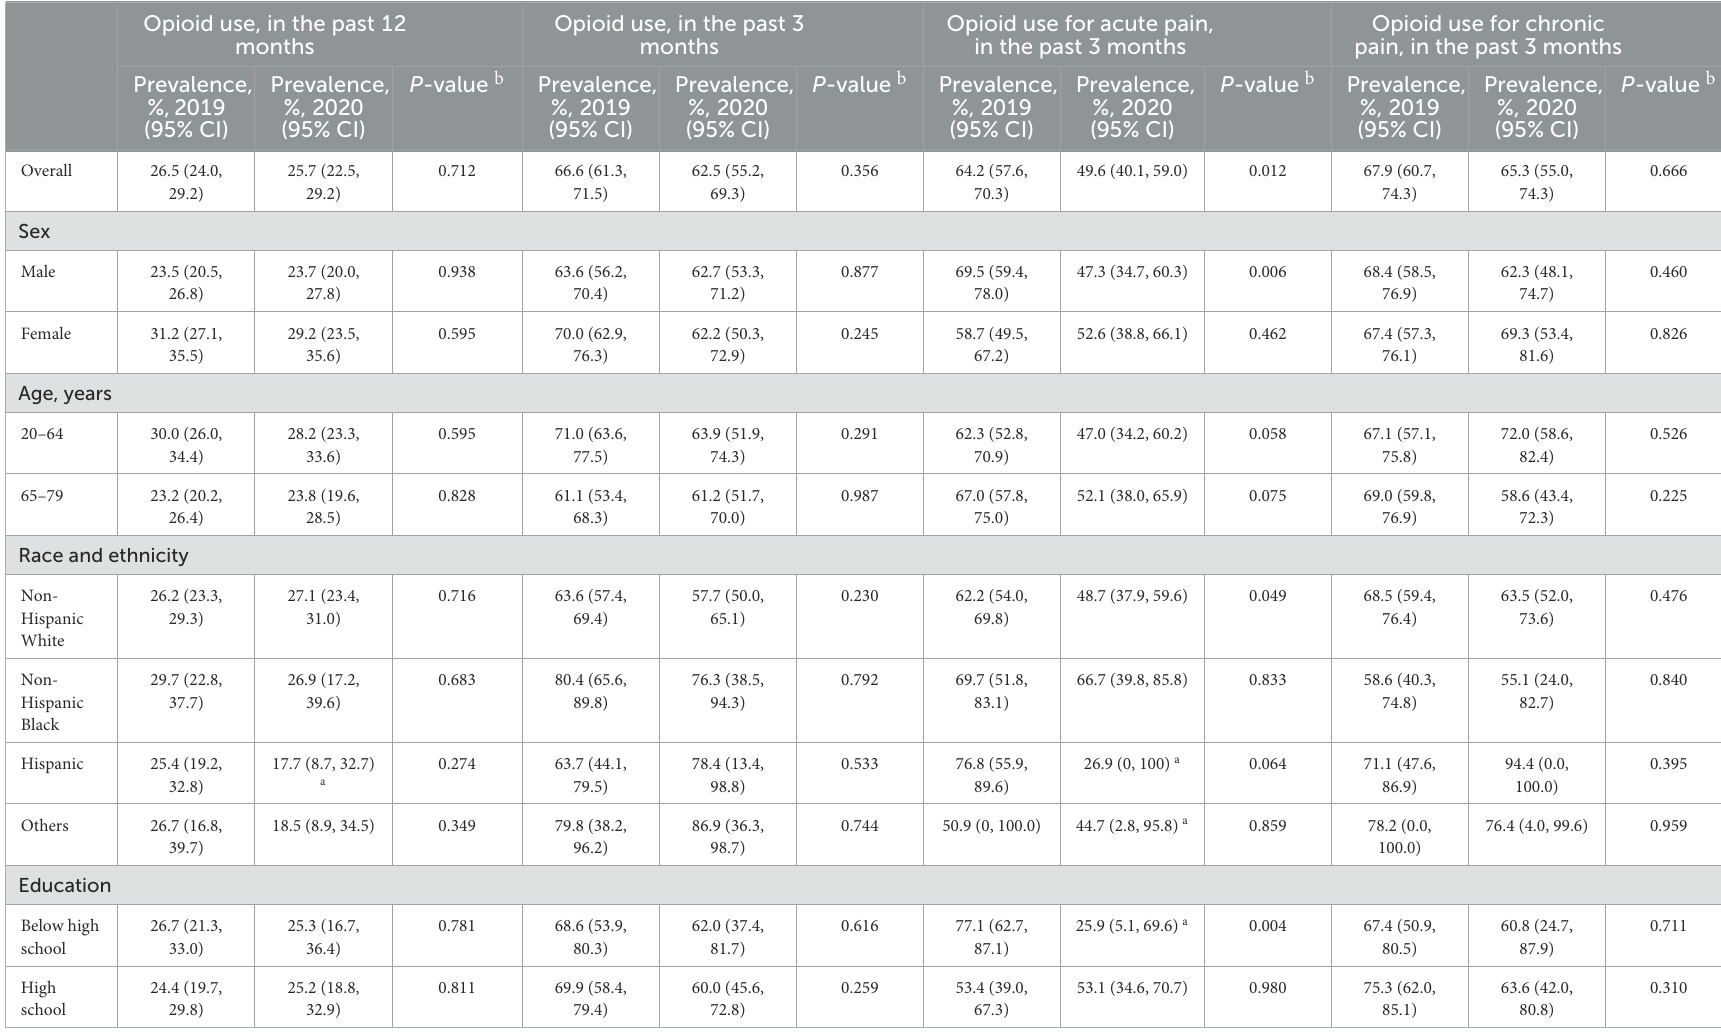
TABLE 2 Comparison of the prevalence of opioid use in 2019 and 2020 by the purpose of use among U.S. adults with cardiac conditions aged 20–79 years. Opioid use, in the past 12 Opioid use, in the past 3 Opioid use for acute pain, months months in the past 3 months